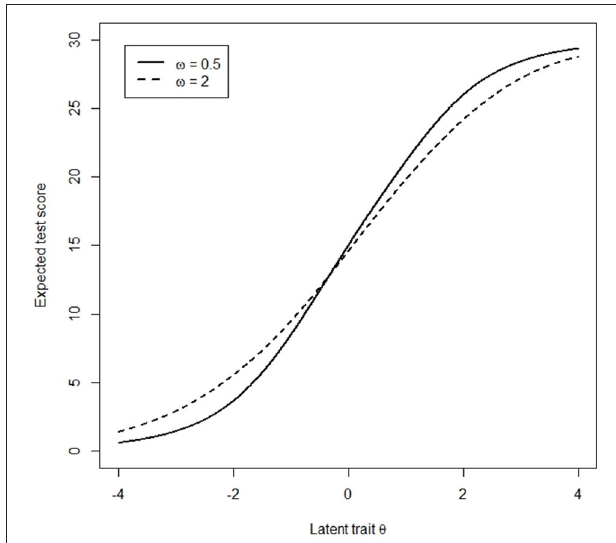
FIGURE 1 | Cumulative test characteristic curves for respondents with different ERS levels.